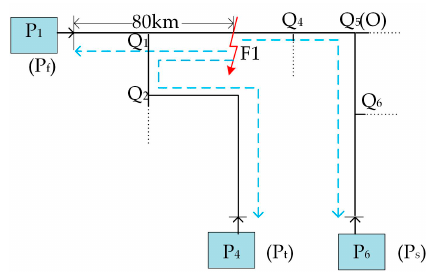
Table 3. Arrival times of the initial traveling wave for fault F1 with fault initialization time = 0.01 s.